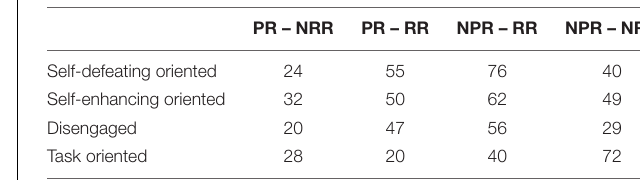
TABLE 4 | Students distribution by retention status and